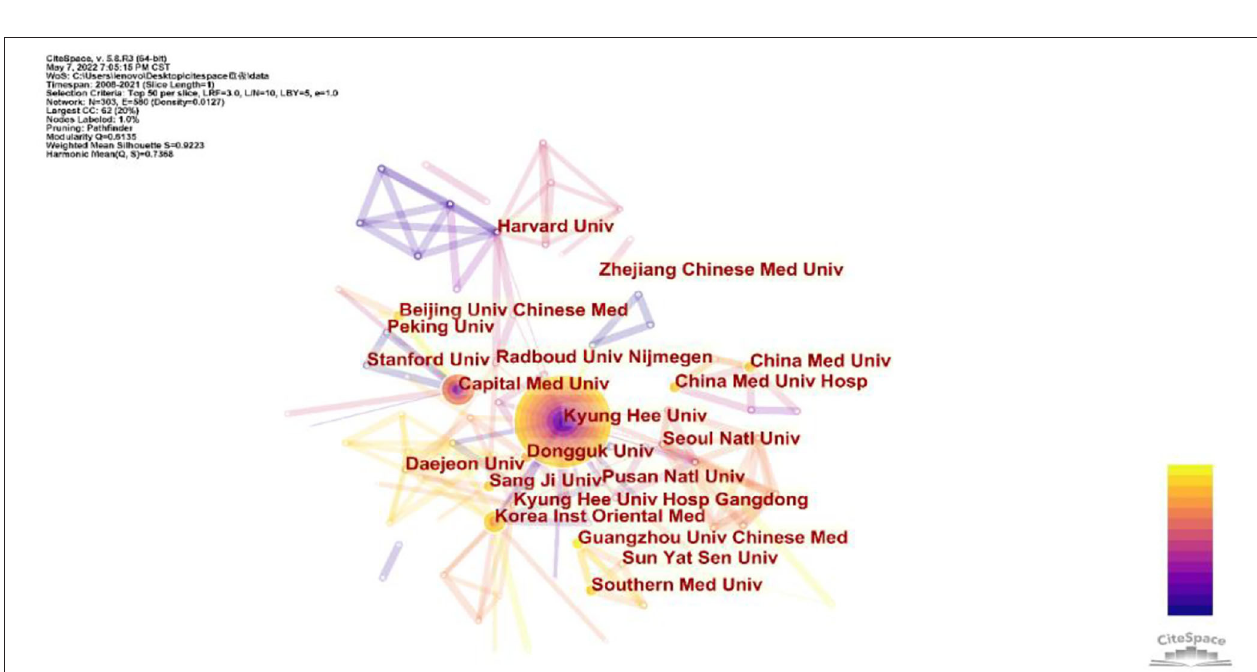
FIGURE 4 | Network map of institutions from Citespace. Each node represents an institution and the size of the node presents the number of publications of that institution. Connections between nodes present the collaborations between the institutions and the thickness of the lines indicates the strength of the cooperation. The purple ring in the inner circle represents the publications from the earliest year and the yellow ring in the outer circle is the most recent publications.